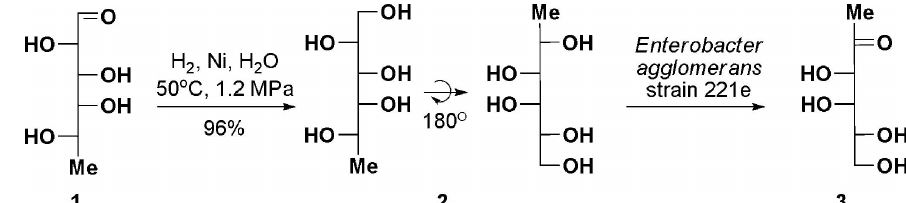
Figure 1 Synthetic scheme.